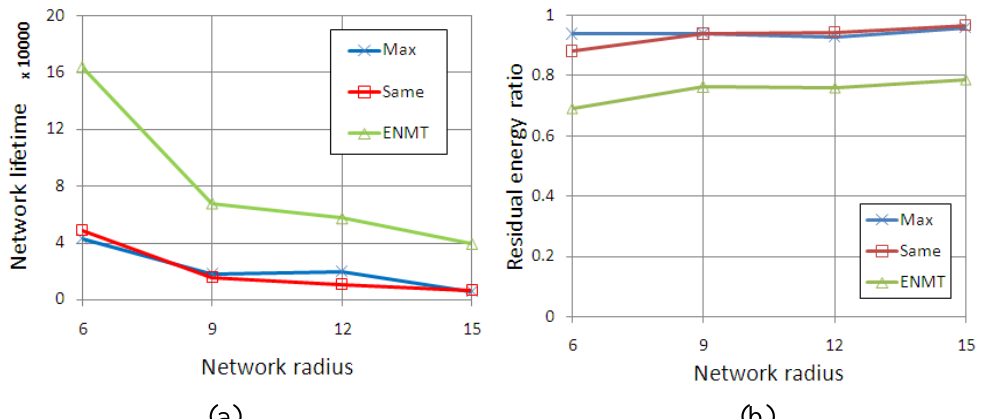
Figure 9. Simulation results (4, 3 and 2). (a) Network Lifetime. (b) Residual energy